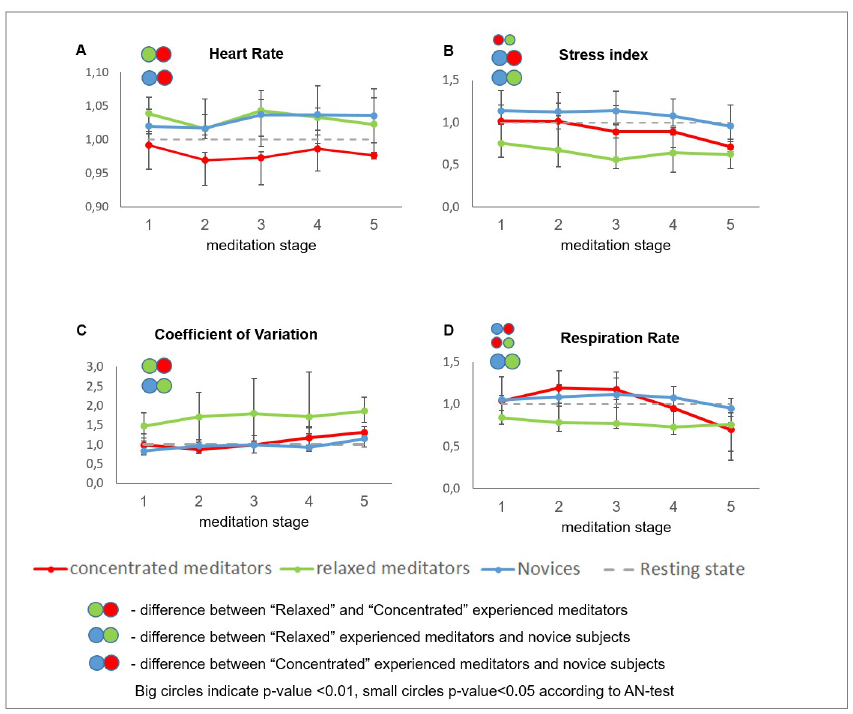
Fig 7. Changes of ANS activity markers in “relaxed” and “concentrated” experienced meditators and novices. Data presented as Median ± IQR.